Question: Write a single sentence explaining what this figure depicts.
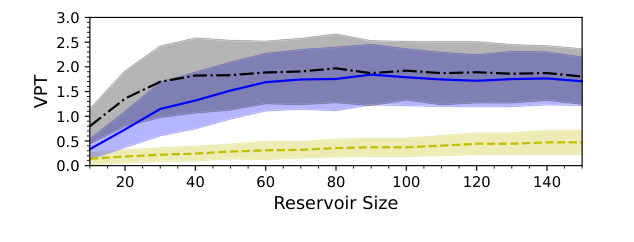
Answer: (a) NRMSE and (b) VPT for classical linear regression (dashed orange line), linear attention (solid blue line), and nonlinear attention-enhanced reservoir computing (dashed-dotted black line) with varying reservoir size N for UCTLS with a forcing strength of zero, essentially making it a classic single Lorenz task. The shaded areas depict the standard deviations of NRMSE and VPT over ten time series.